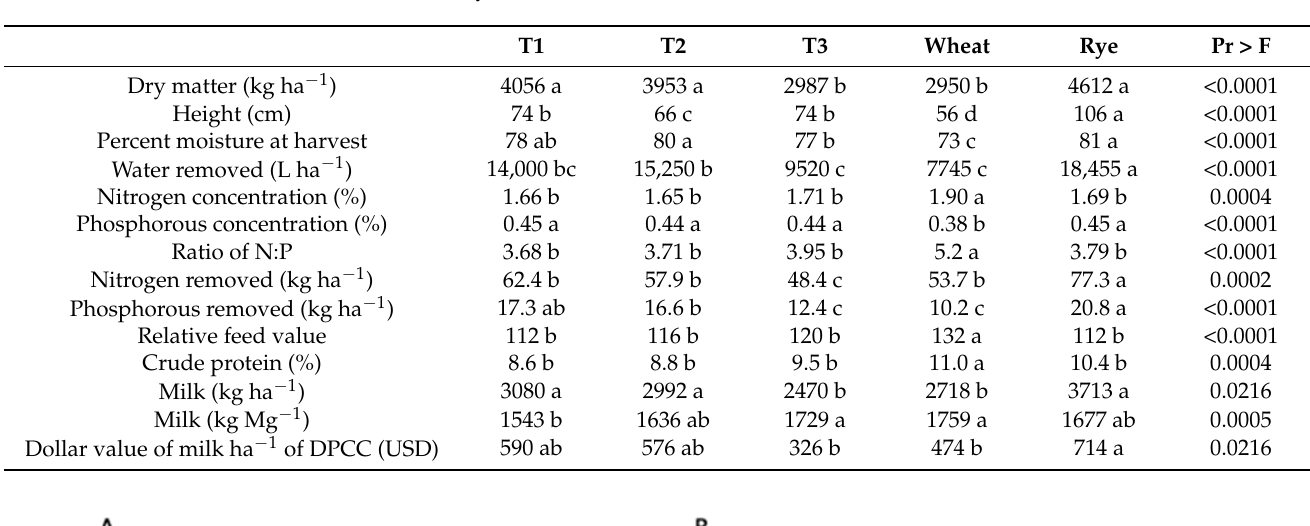
vest. Means separated by Tukey’s HSD range test. Within the same row, values followed by differ- ent letters are statistically different. Values are averages of two years. Trical 815 (T1); NE426GT (T2); T3 (variety not stated.